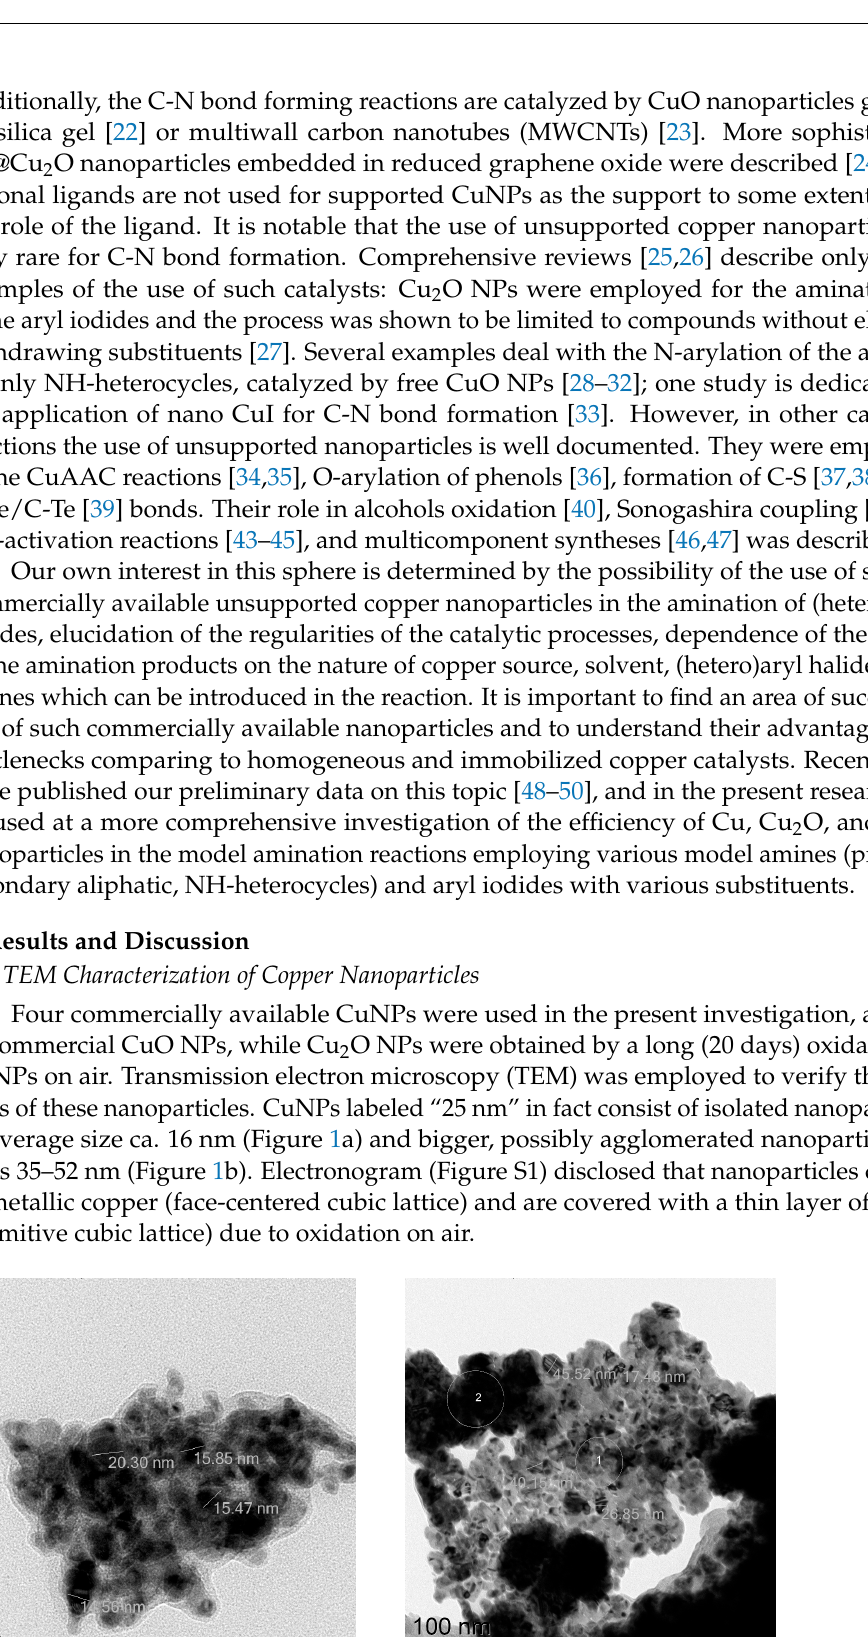
Figure 2. TEM image of CuNPs of the average particles size 72 nm. Cu NPs claimed “60 nm” indeed possess isolated nanoparticles of the average size of 86 nm (Figure 3a) which are covered with a substantial layer of copper (I) and (II) oxides (Figure 3b). This was verified by the electronogram (Figure S3).